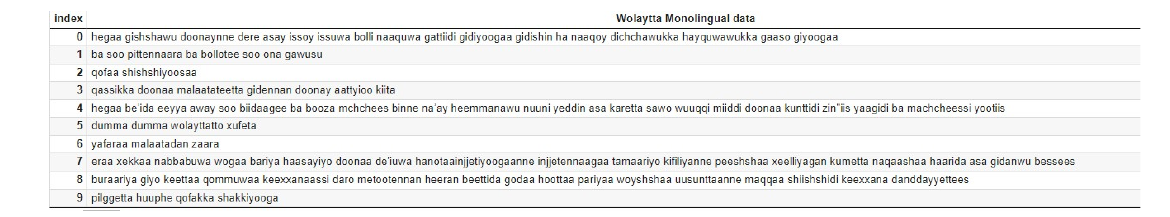
Figure 5. Sample texts from Wolaytta–English parallel dataset.